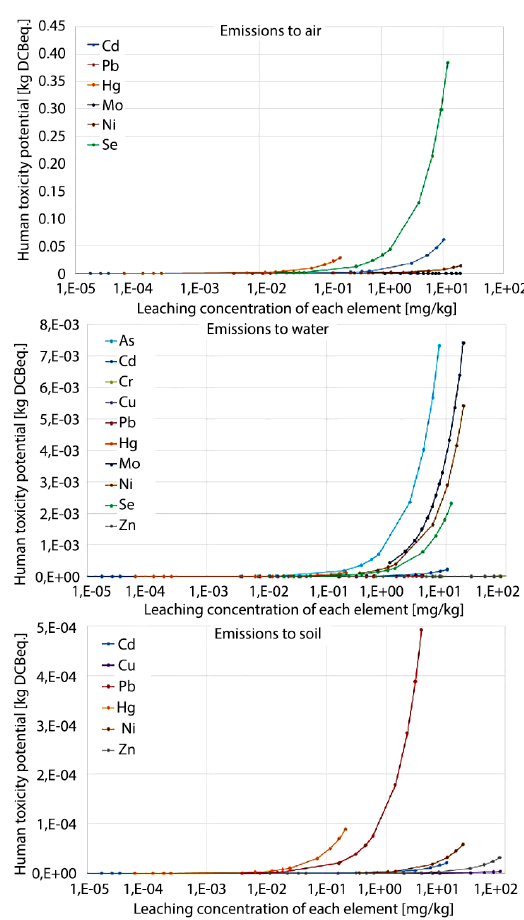
Figure 5. LCA model results – HTP dependence on leaching concentrations of selected heavy